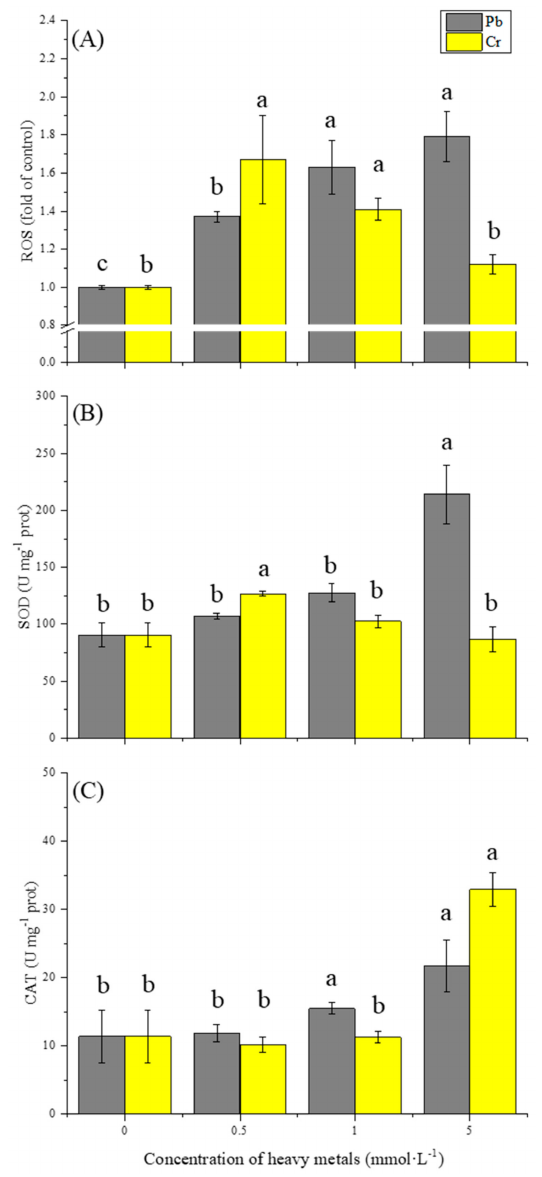
Figure 3. E ff ects of Pb and Cr on ROS generation ( A ), antioxidative enzymes activities of SOD ( B ) and CAT ( C ). Bars with di ff erent letters (a–c) are significantly di ff erent at p <